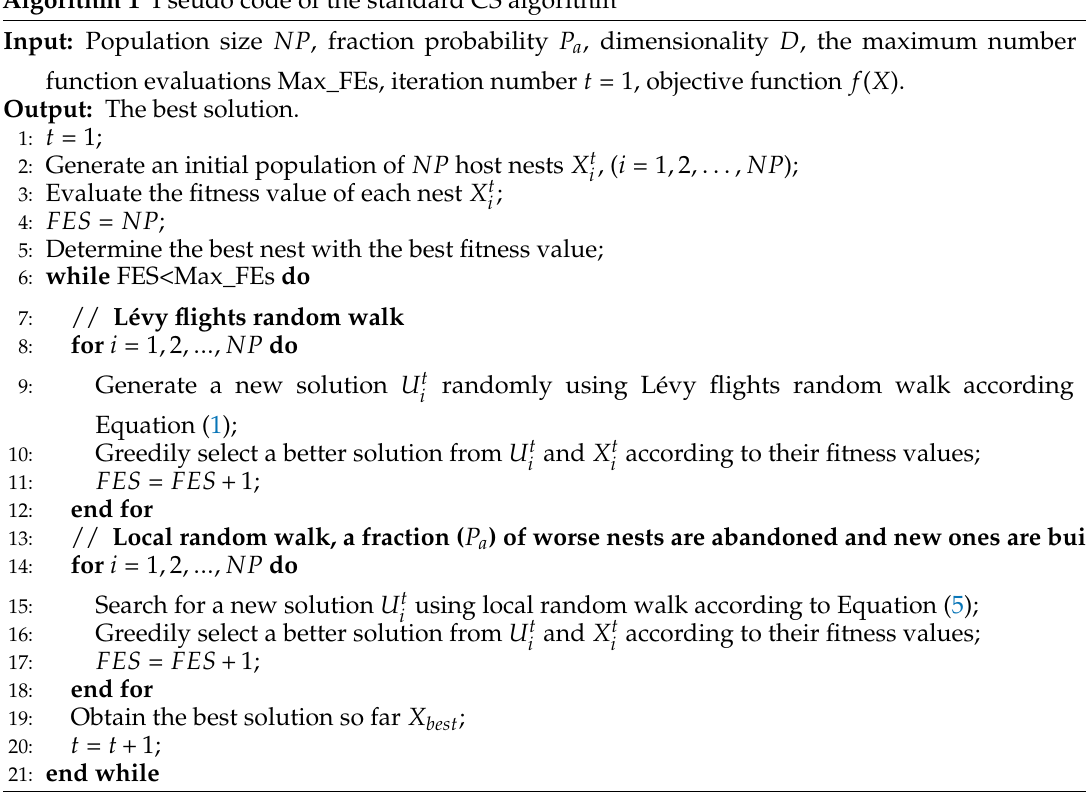
Algorithm 1 Pseudo code of the standard CS